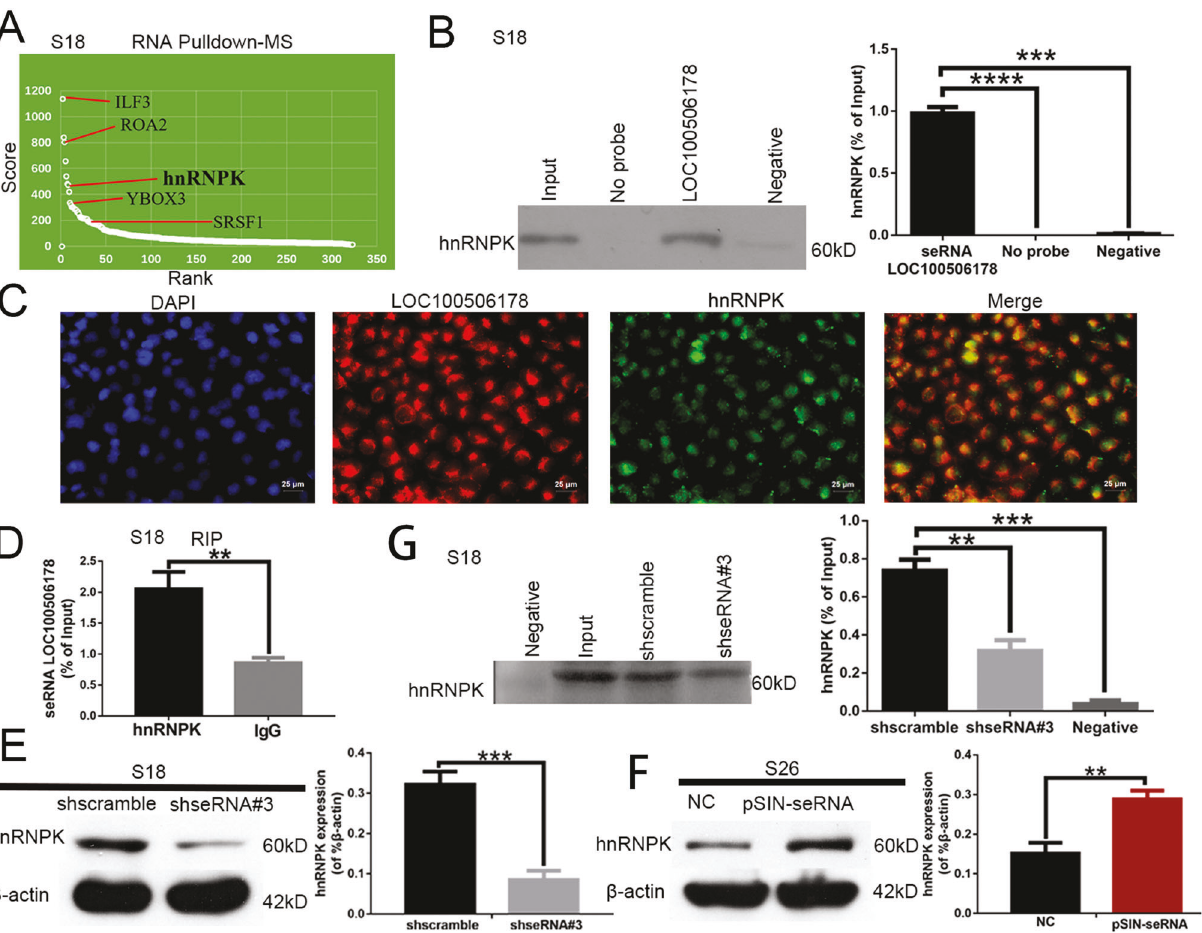
Fig. 5 seRNA LOC100506178 speci fi cally regulated hnRNPK. A Biotin-labeled RNA pull-down-MS assay was used to detect the interaction of seRNA LOC100506178 with hnRNPK in S18 cells; antisense RNA for LOC100506178 was used as a negative control. B The interaction of seRNA LOC100506178 with hnRNPK was con fi rmed by RNA pull-down western blotting, and the enrichment level of hnRNPK was analyzed; antisense RNA for LOC100506178 was used as a negative control, no probe served as a blank control. C Co-localization between LOC100506178 and hnRNPK was veri fi ed with RNA FISH and immuno fl uorescence microscopy. D hnRNPK RIP and RT-qPCR assays were performed to verify the enrichment level of hnRNPK with LOC100506178 in S18 cells; rabbit normal IgG antibody was used as a negative control. E , F The levels